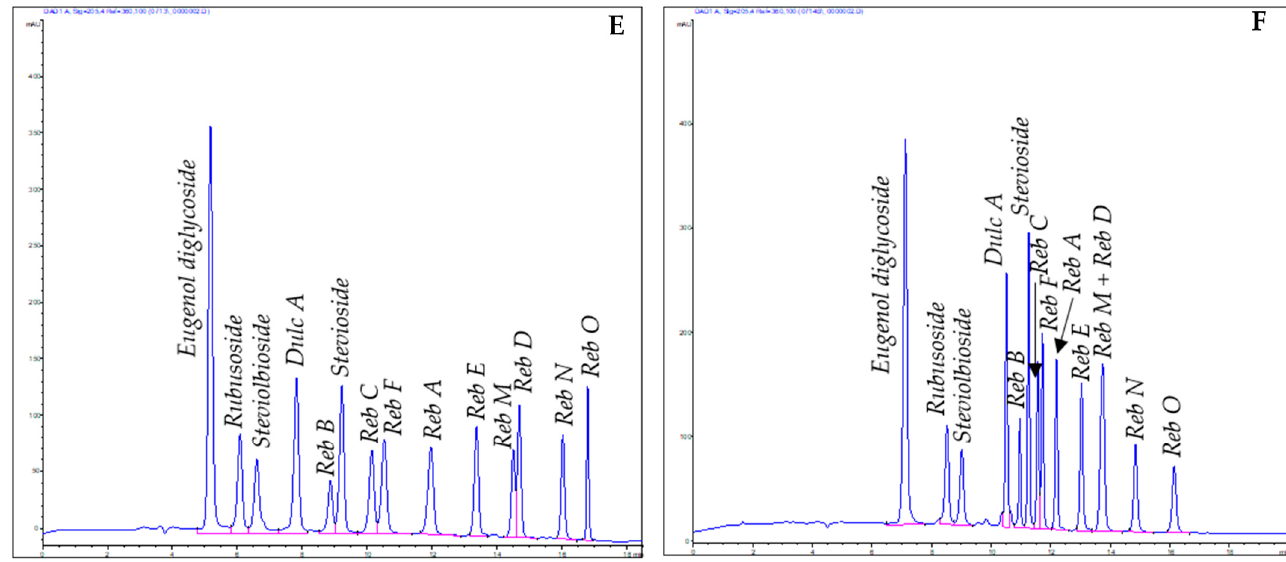
Figure 4. Selected HPLC methods used for the analysis of steviol glycosides: silica method ( A ), RP-C18 ( B ), Synergi ( C ), amino ( D ), HILIC ( E ) and Sepax-diol ( F